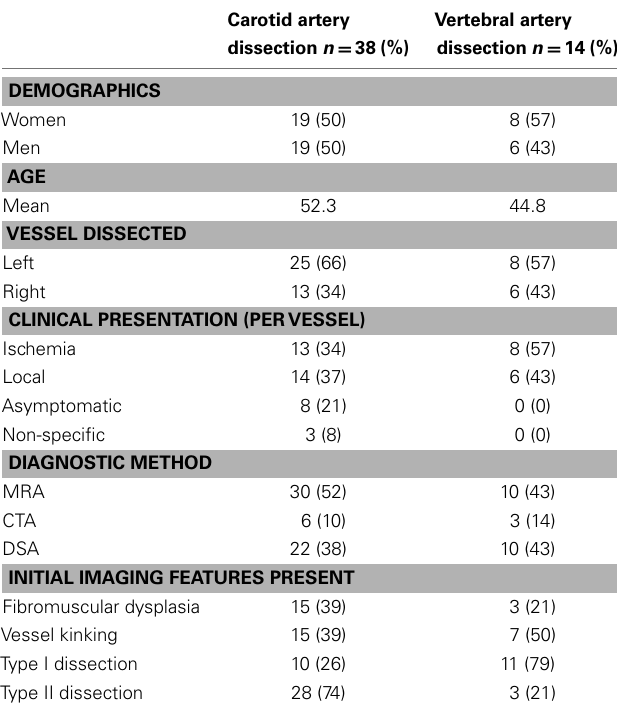
Table 1 | Characteristics of carotid and vertebral artery